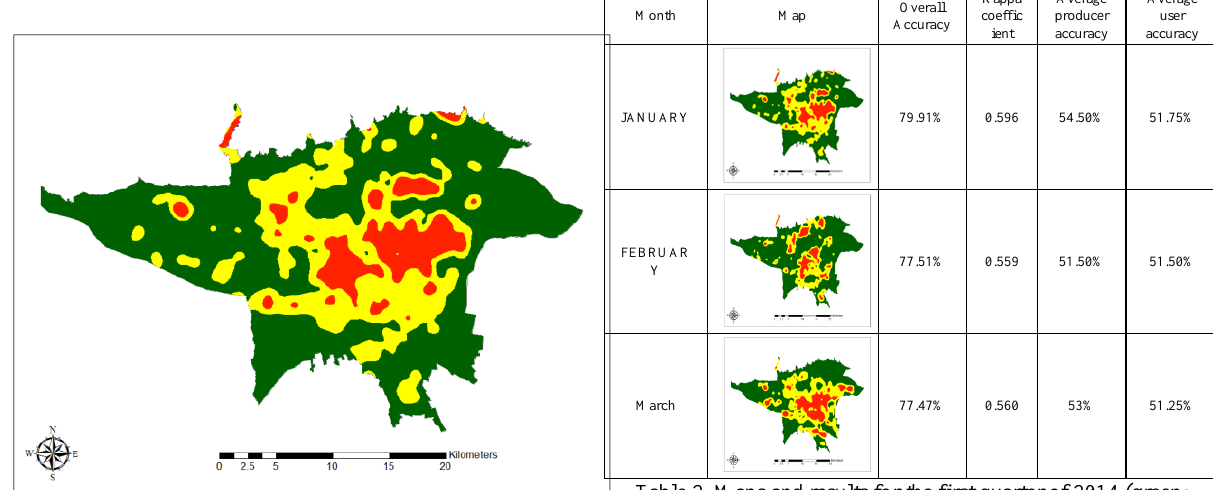
Table 2. Maps and results for the first quarter of 2014 (green: Figure 2. Density map of carbon monoxide pollution in Tehran Clear, Yellow: low density, red: high for January 2014 (green: Clear, Yellow: low density, red: high density)